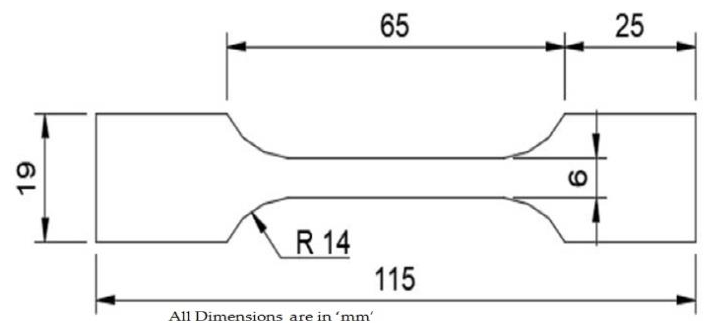
Figure 1. ASTM D638 specimen.